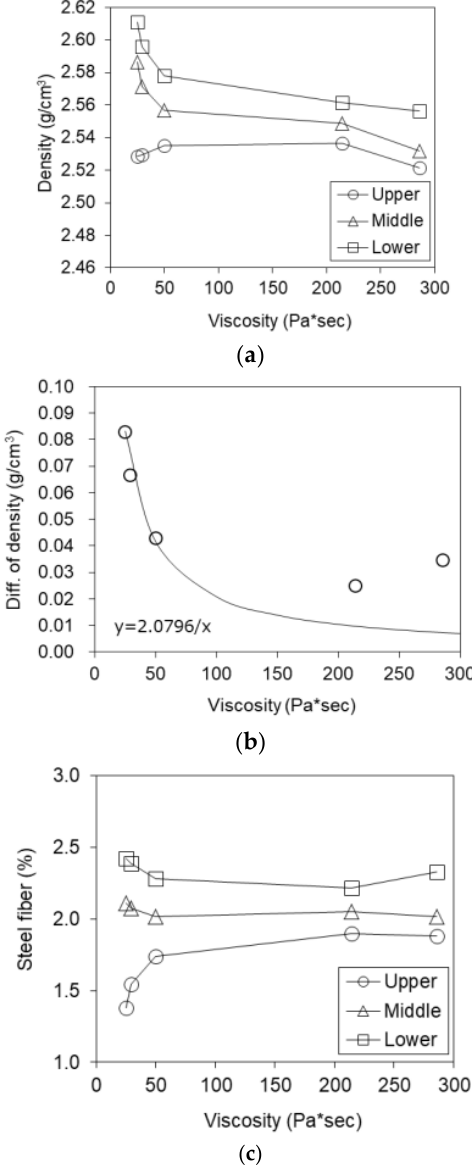
Figure 26. Results of steel-fibre segregation. ( a ) Densities of upper, middle, and lower parts. ( b ) Density difference. ( c ) Estimated steel fibre contents.